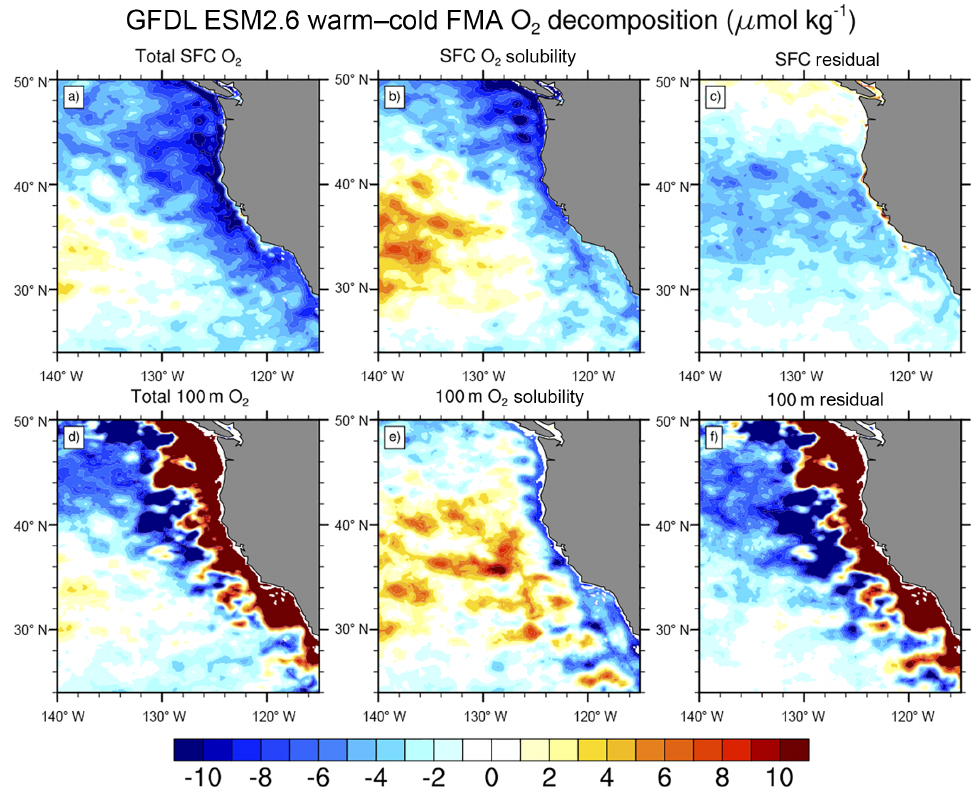
Figure 8. ESM2.6 FMA warm–cold high-pass-filtered anomalies (µmolkg − 1 ) for O 2 and its components (a) surface total O 2 , (b) O 2 due to (cid:49) surface temperature (solubility), (c) residual surface processes, and (d) 100m total O 2 , (b) O 2 due to (cid:49) 100m temperature (solubility), (c) residual 100m